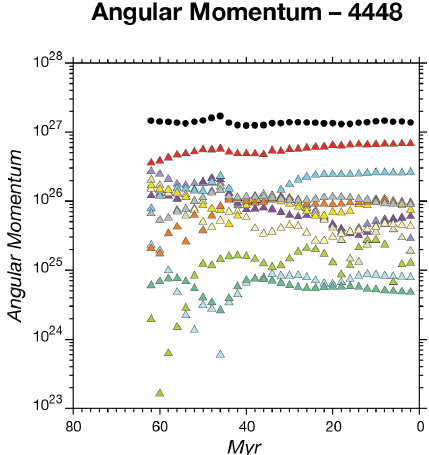
Figure 10. Angular momentum vs. Myr for 4448 individual filtered plate data over 62–0Myr of Bowin (2010) and their sum (black cir- cles). Plate ID for plates: AF (Africa, dark grey), AN (Antarctica, dark blue), CA (Caribbean, dark green), CO (Cocos, yellow green), EN (Eurasia, light yellow), IN (India, pale yellow), NA (North America, dark yellow), NZ (Nazca, orange), PA (Pacific, red), and SA (South America, light